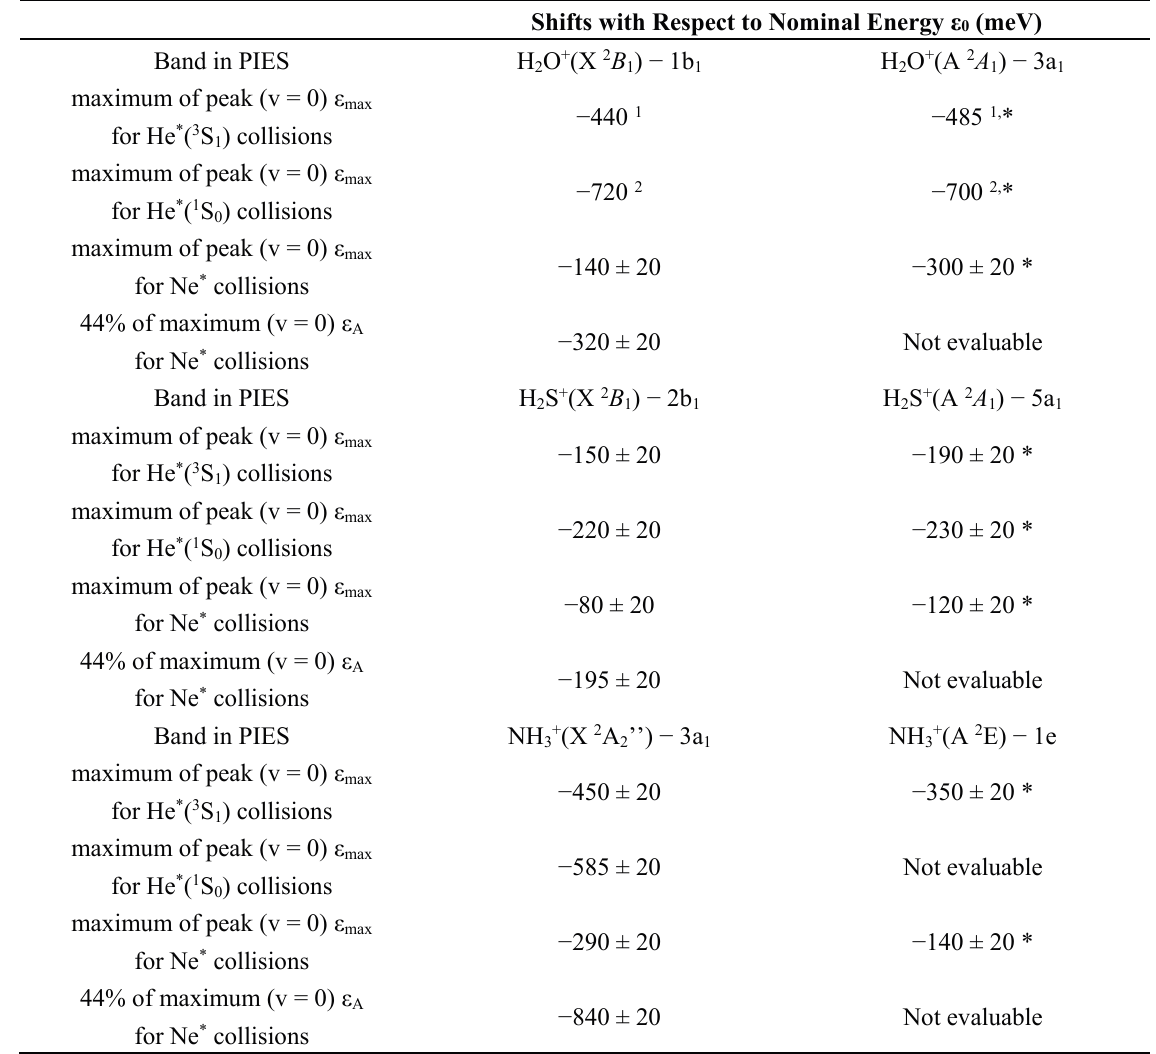
Table 2. Negative energy shifts from the PIES He * and Ne * -H 2 O, H 2 S and NH 3 spectra measured at an average collision energy of 70 and 55 meV,